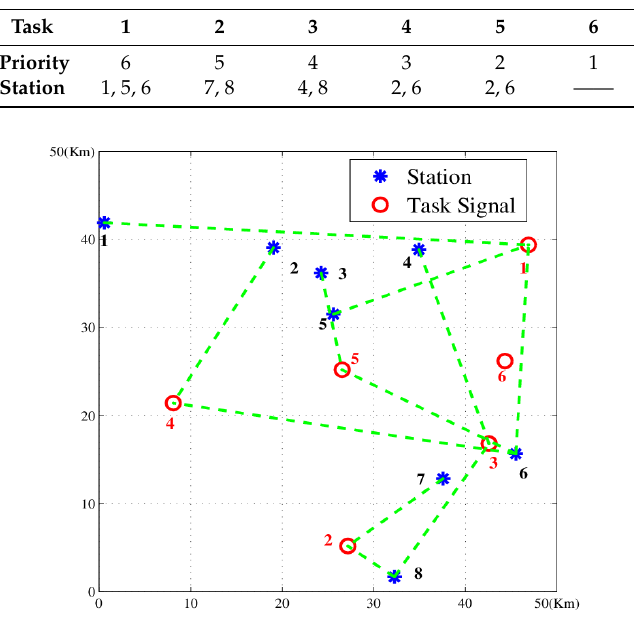
Figure 18. Experiment results of eight stations and six tasks.